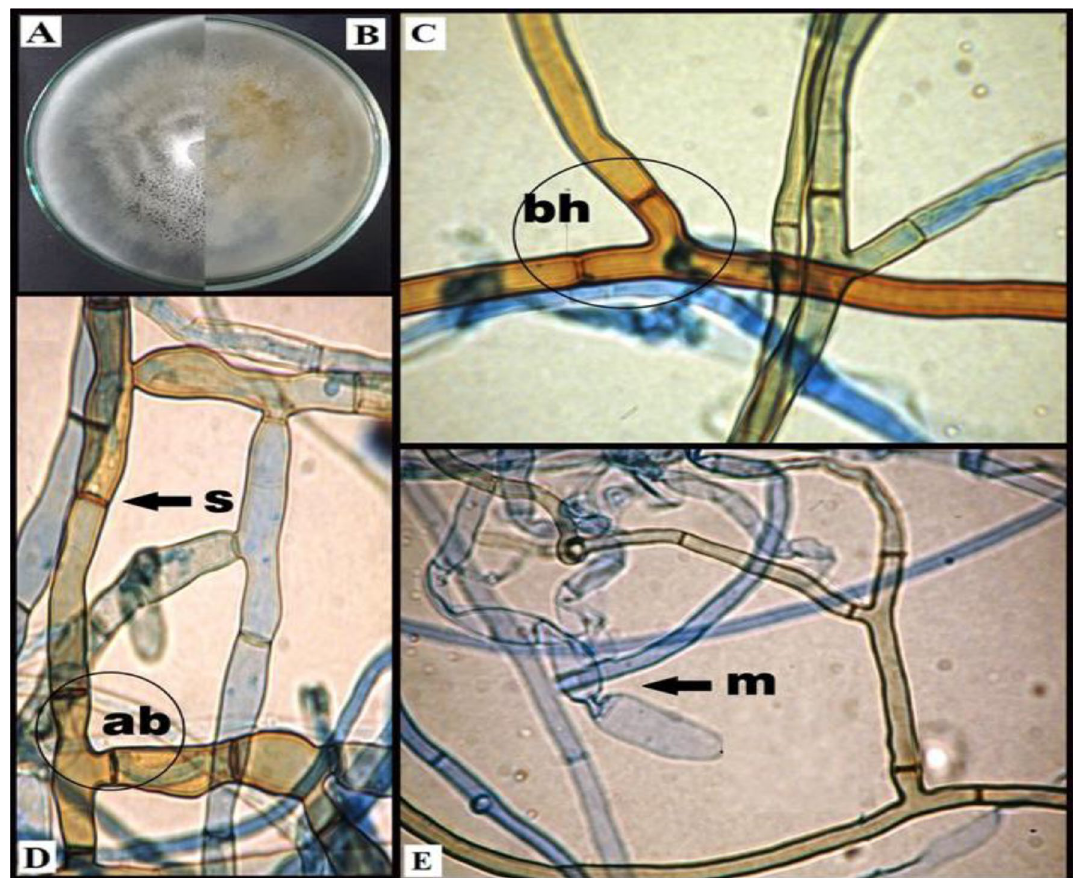
Figure 4. Morphological and microscopic characteristics of Rhizoctonia solani fungus isolated from basal stems and roots of bamboo plants, ( A , B ): mycelial of R. solani on PDA medium after 10 days (A: top surface and A: lower surface) for the petri dish, and ( C , D & E ) microscopic traits of R. solani of the hyphal stage at a typical angle branching (ab) with numerous branching filaments of specialized hyphae composed of compact cells called monilioid cells (m), branching hyphae (bh) and septum